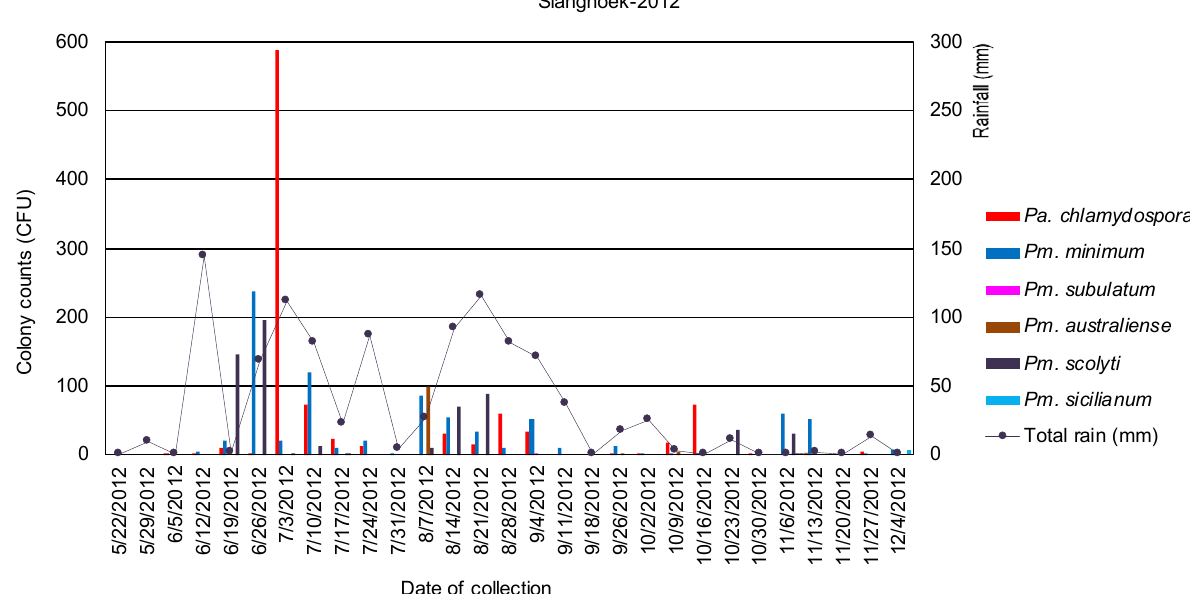
Figure 13. Phaeomoniella and Phaeoacremonium spp. cfu cultured from five vaseline coated microscope slides affixed to each of five rootstock mother vines in a rootstock mother block in Slanghoek, Western Cape province in 2012. The slides were replaced weekly. Each bar represents the total number of cfu cultured on three Petri dishes. Not clear on the graph, detection dates for Pm. subulatum are 04/09 and 16/10.